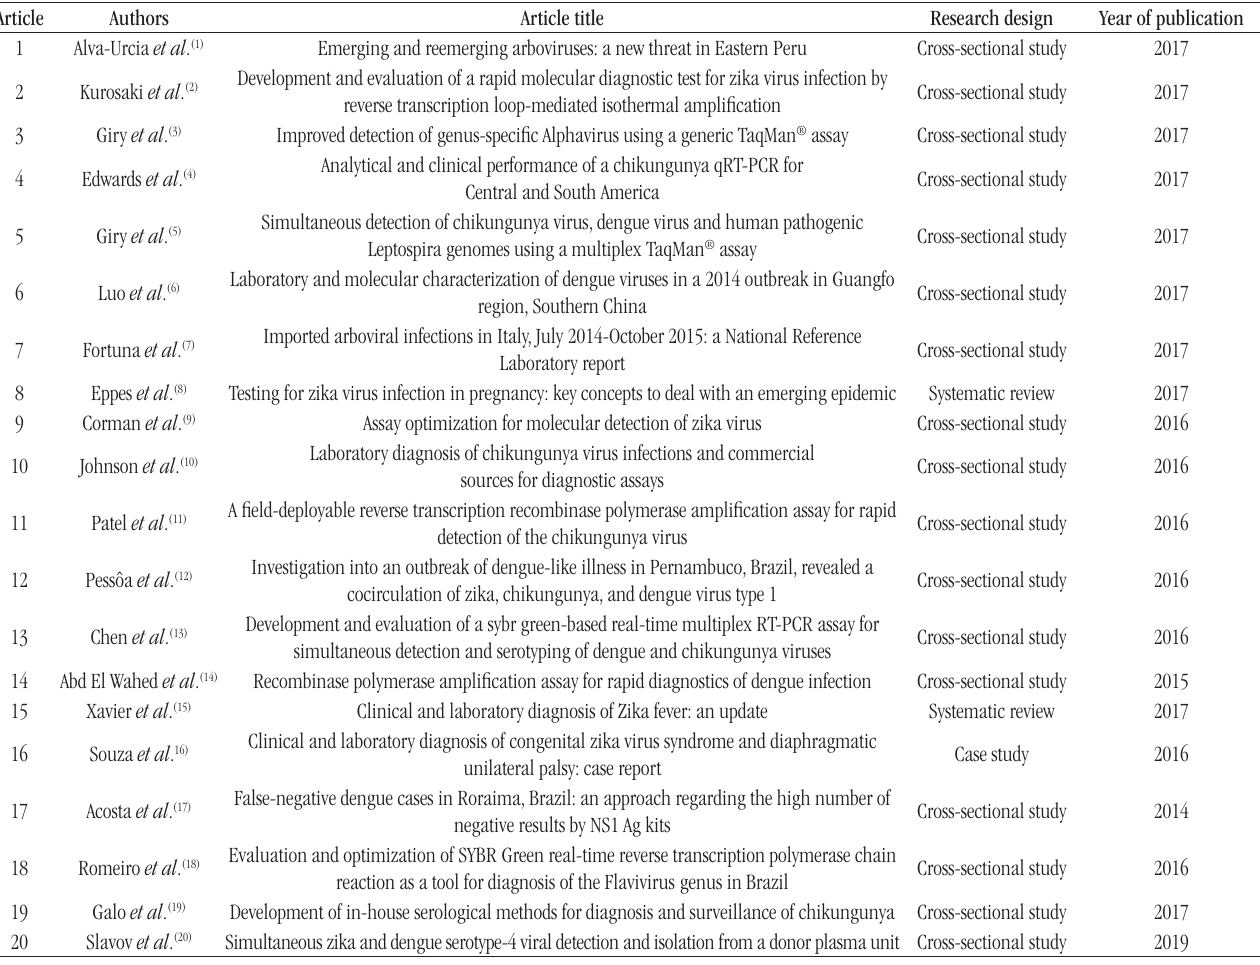
TABLE 1 – Articles selected during the stages of integrative review